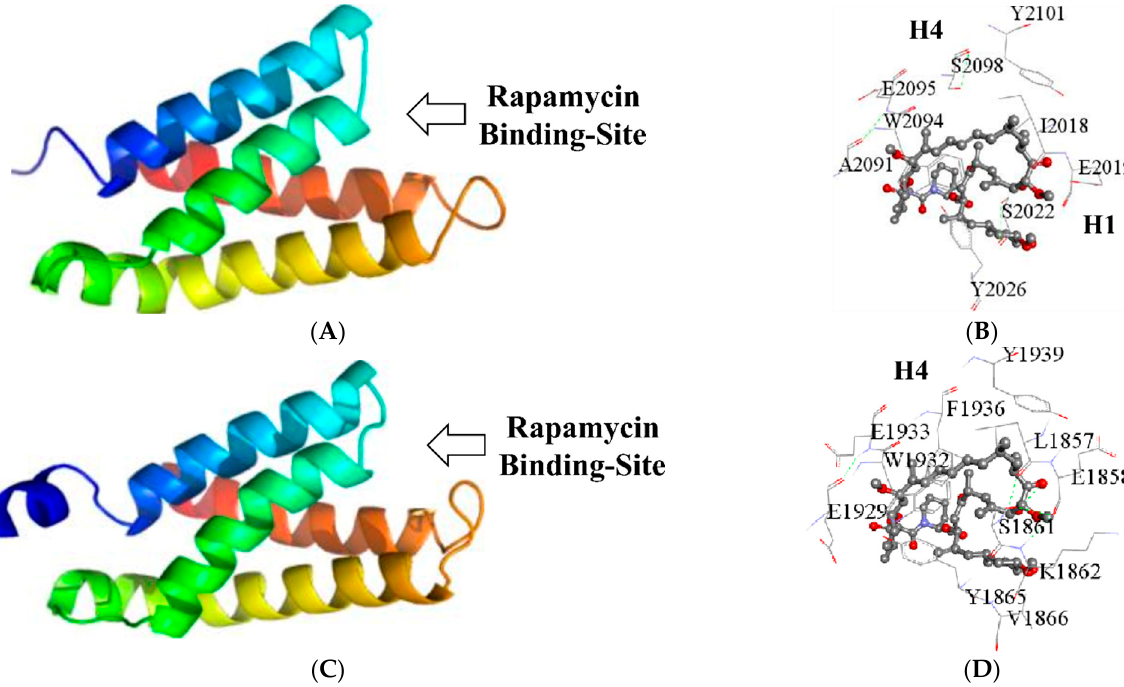
Figure 5. Predicted tertiary structure for the rapamycin-binding domain (RBD) of both TOR-like amoebic proteins. Best 3D model (ribbon representation) for the RBD of Eh FRAP ( A ) and Eh TOR2 ( C ). Rainbow-colored from amino (blue) to carboxy (red). An arrow indicates the respective predicted rapamycin binding-site. Best models for the ligand-binding cleft and residues interacting with rapamycin: Eh FRAP ( B ) and Eh TOR2 ( D ). H1 and H4 show the relative locations of the respective α -helix 1 and α -helix 4. Rapamycin (balls and sticks) is colored by element using the default settings.